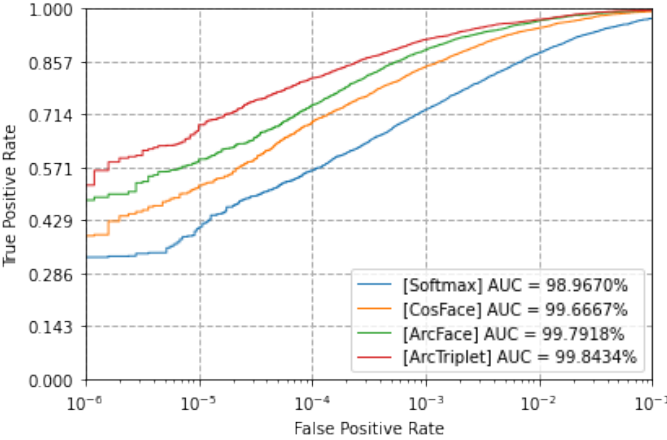
Figure 5. ROC curves of ArcFace + Triplet, ArcFace, CosFace and Sotmax on